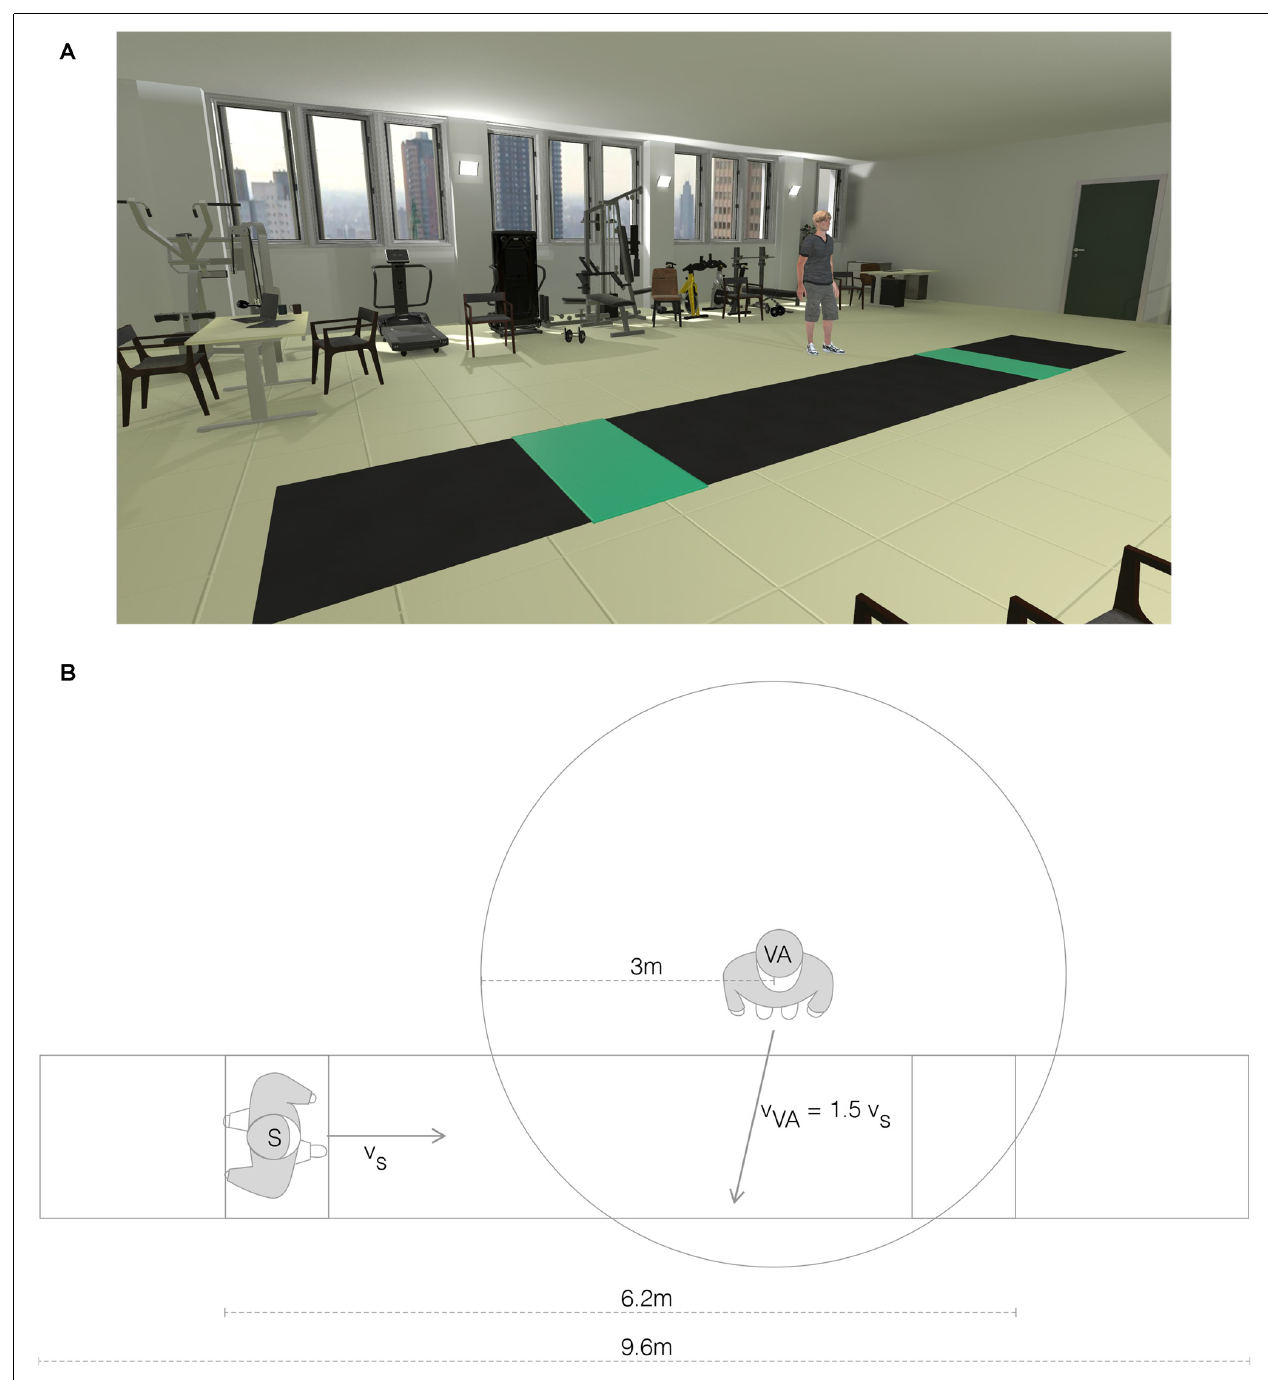
FIGURE 2 | Virtual reality environment. (A) View of the virtual reality (VR) environment with the virtual agent (VR/A+ condition). (B) Top view schema of the VR environment representing the relative positions of the subject (S) and the virtual agent (VA).